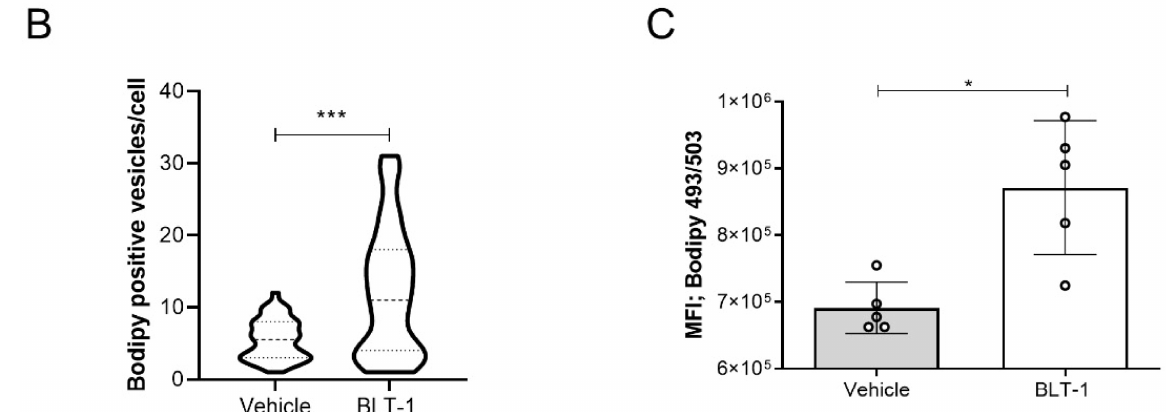
Figure 6. BLT-1-induced changes in cytoplasmic neutral lipid accumulation in primary bovine umbilical vein endothelial cells (BUVEC). ( A ) Live cell 3D holotomography analysis in combination with BODIPY 493/503-driven epifluorescence of the vehicle- or BLT-1-treated BUVEC. ( B ) Violin plot depicting the number of LDs in the vehicle- or BLT-1-treated BUVEC. ( C ) BODIPY 493/503-based mean fluorescence intensity in the vehicle- or BLT-1-treated BUVEC detected by FACS analyses. Bars represent the means of five biological replicates ± standard deviation. White arrows indicate LD-like structures. Scale bar: 5 µ m. * p ≤ 0.05; *** p ≤ 0.001.